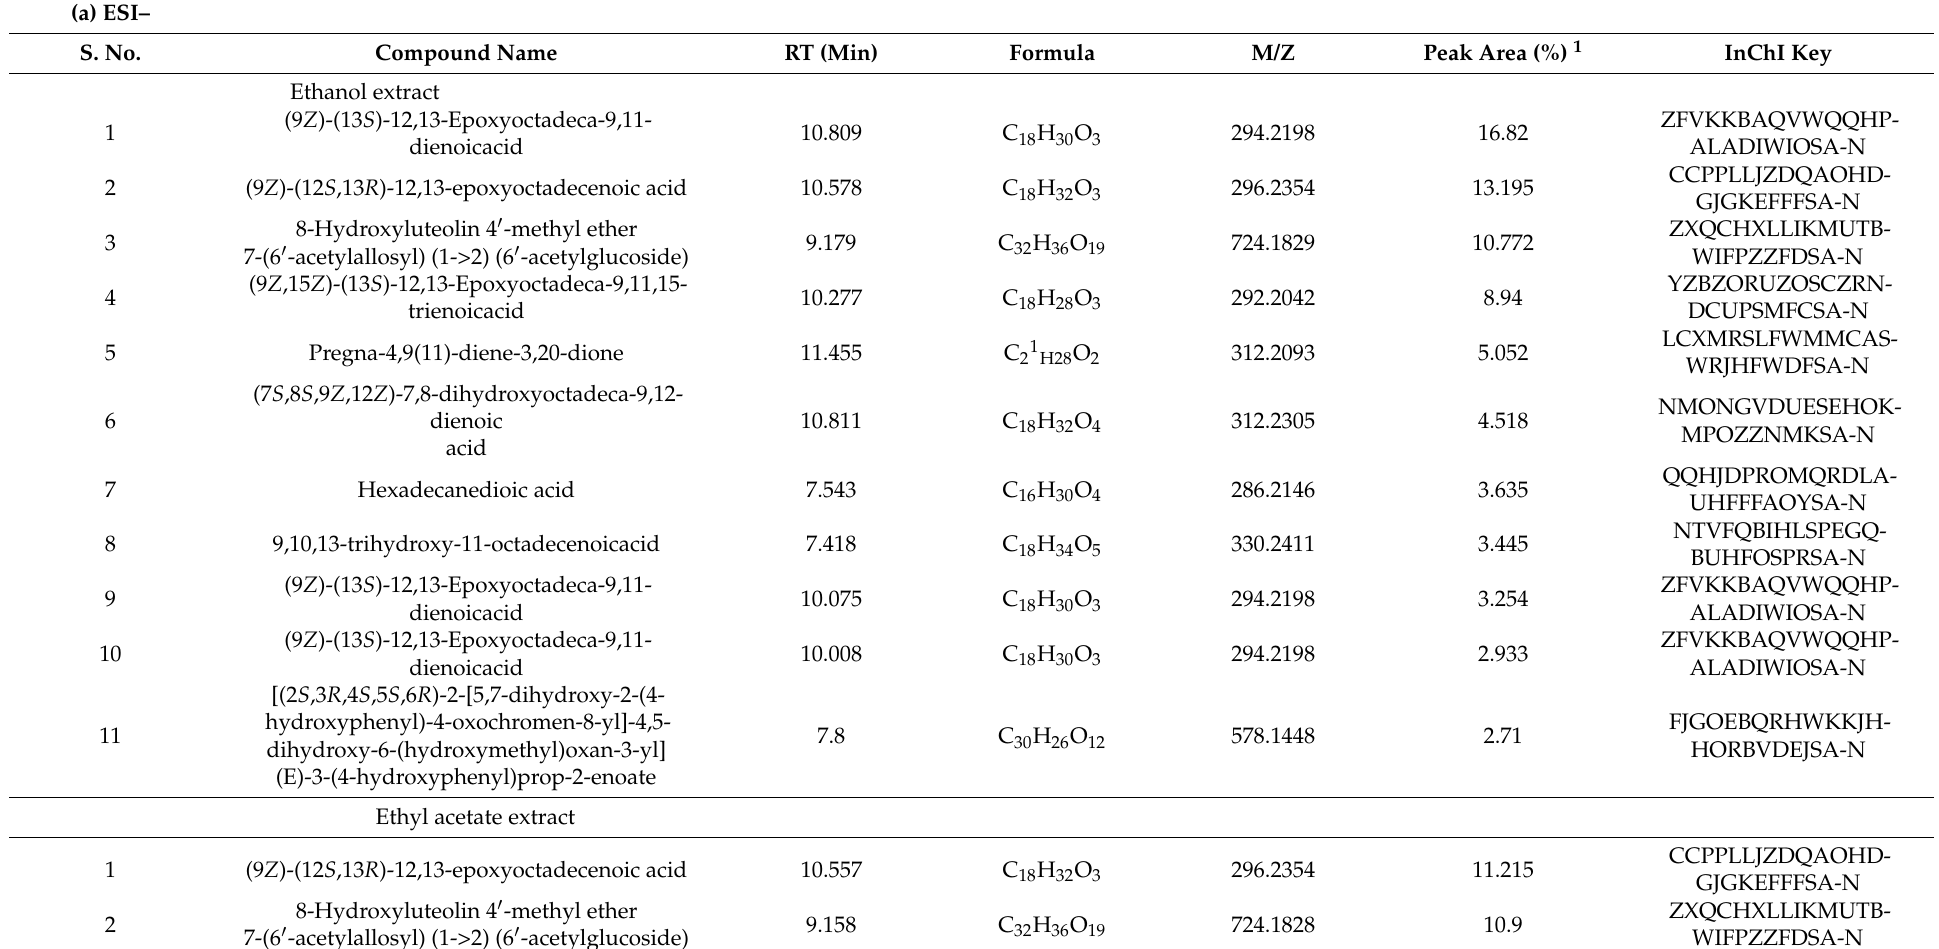
Table 1. Major constitutes of different solvent E. foeminea crude extracts analyzed by (a) ESI − and (b) ESI+ mode